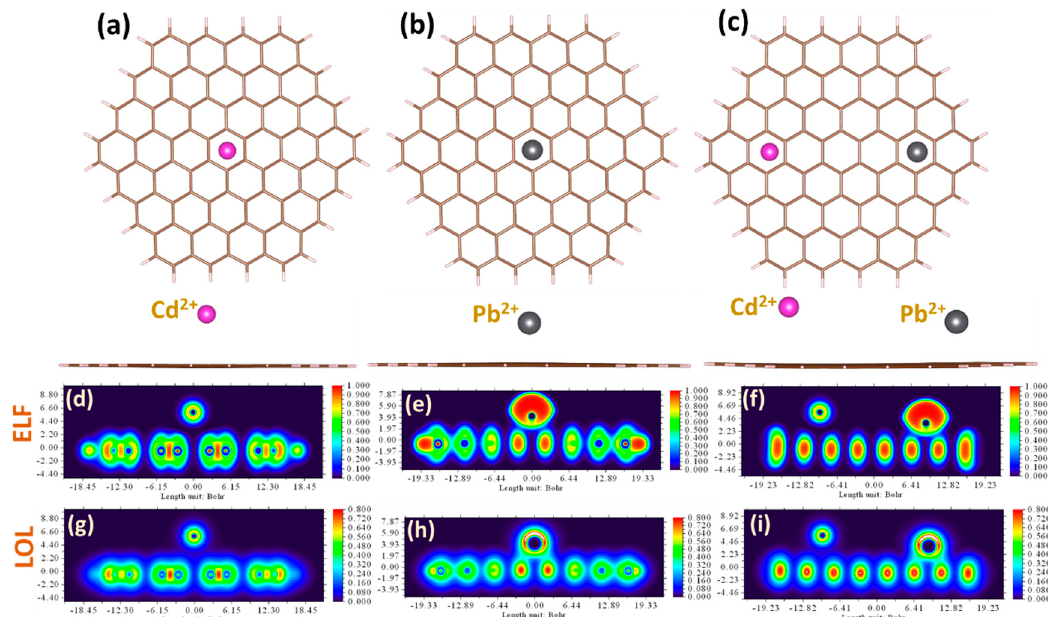
Figure 2. Top view and side view of the relaxed adsorption configurations of Cd 2 + ( a ), Pb 2 + ( b ), and simultaneous presence of Cd 2 + and Pb 2 + divalent ions ( c ), on the graphene surface. Contour plots of the electron localization function (ELF) and color-filled maps of localized orbital locator (LOL) for the heavy metal ions adsorbed onto graphene: Cd 2 + on Gr ( d , g ), Pb 2 + on Gr ( e , h ), and Cd 2 + and Pb 2 + on Gr ( f , i ), respectively.